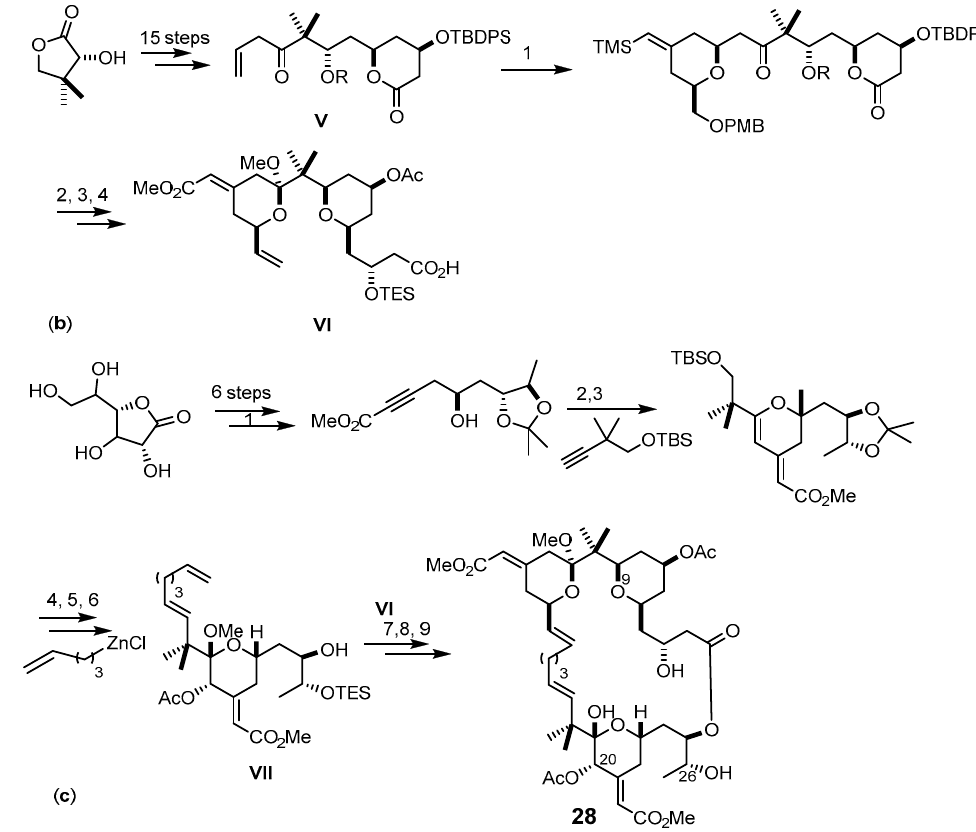
Scheme 4. Synthesis of the methyl bryostatin 1 ( 25 ) analogs 27 ( a ) and 28 ( b , c ). Reagents and conditions